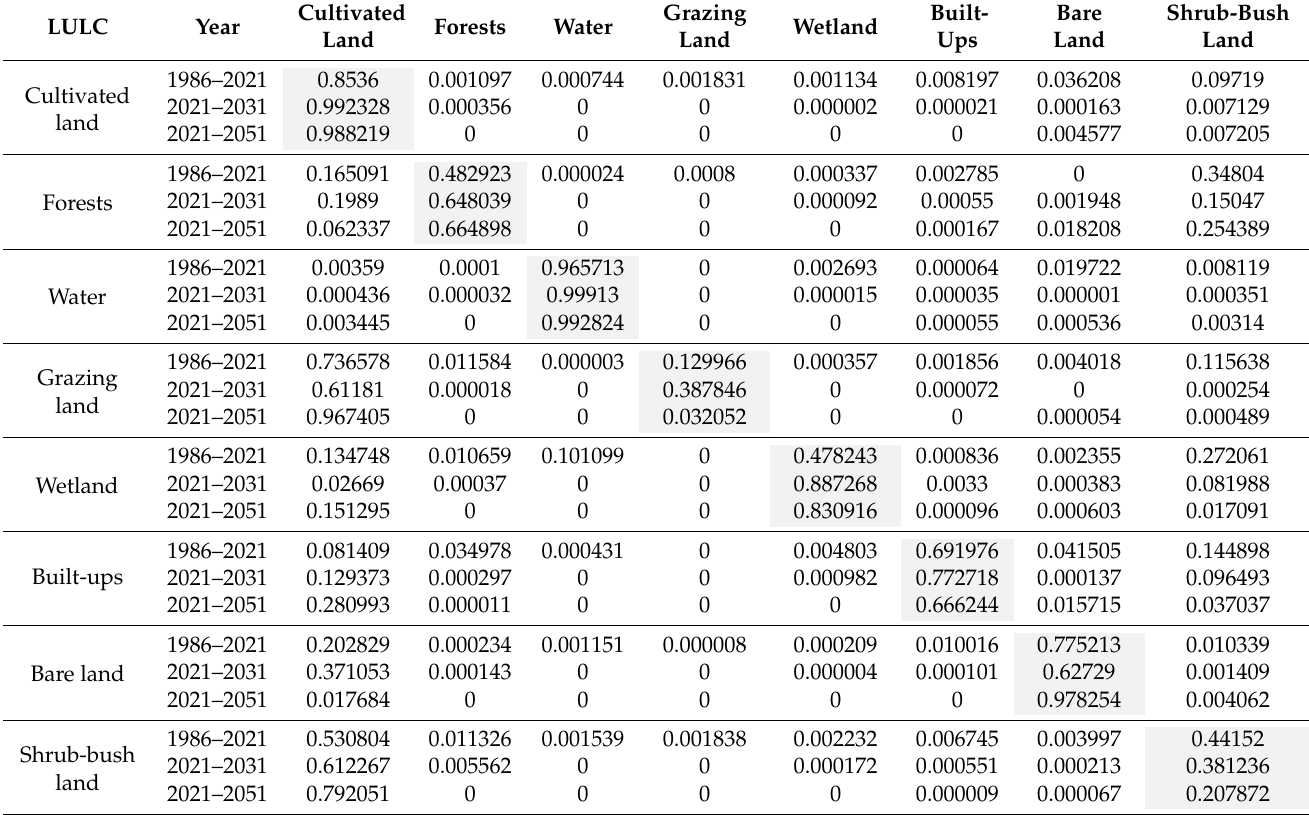
Table A1. Land use land cover (LULC) transition probability matrix of 1986 and 2021; 2021 and 3031 and